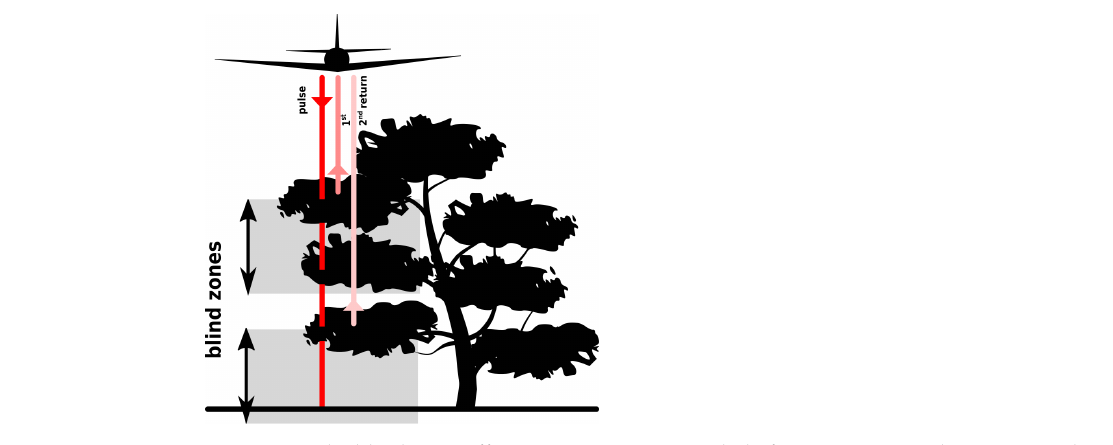
Figure 14. The blind-zone effect, i.e., no points recorded after a given record, may cause the omission of points in certain parts of the vegetation or on the ground. Emitted pulse penetrates the canopy and produces returns. The first return is from top of the canopy and is registered by a detector. Then, no further returns from the canopy are registered until the detector is ready to record another return (top gray rectangle). When the detector is ready to register again, the second return is recorded from the lower parts of the canopy. Again, no further returns from the canopy or ground are registered because the detector is not ready to record (bottom gray rectangle).